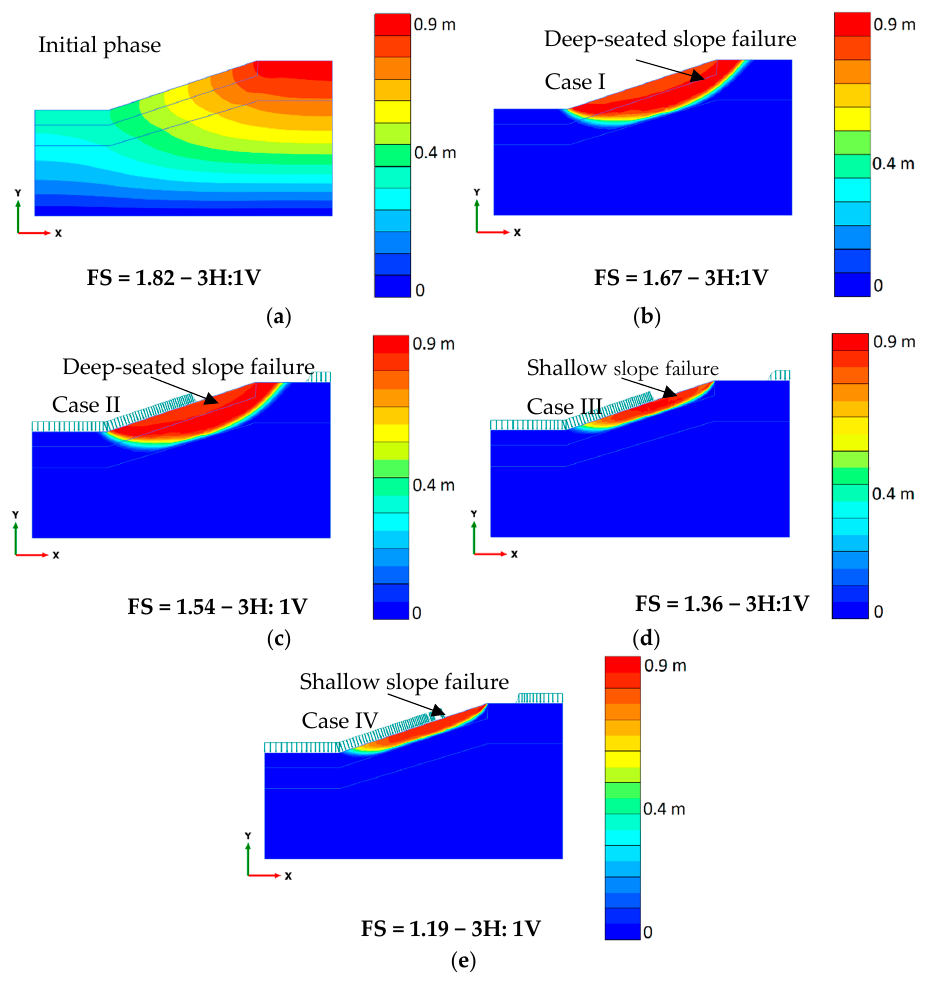
Figure 10. Phi-C reduction analysis results for 126.2 mm rainfall volume for one-day rainfall duration for 3H:1V slope ratio: ( a ) before rainfall ( b ) Case I ( c ) Case II ( d ) Case III ( e ) Case IV.